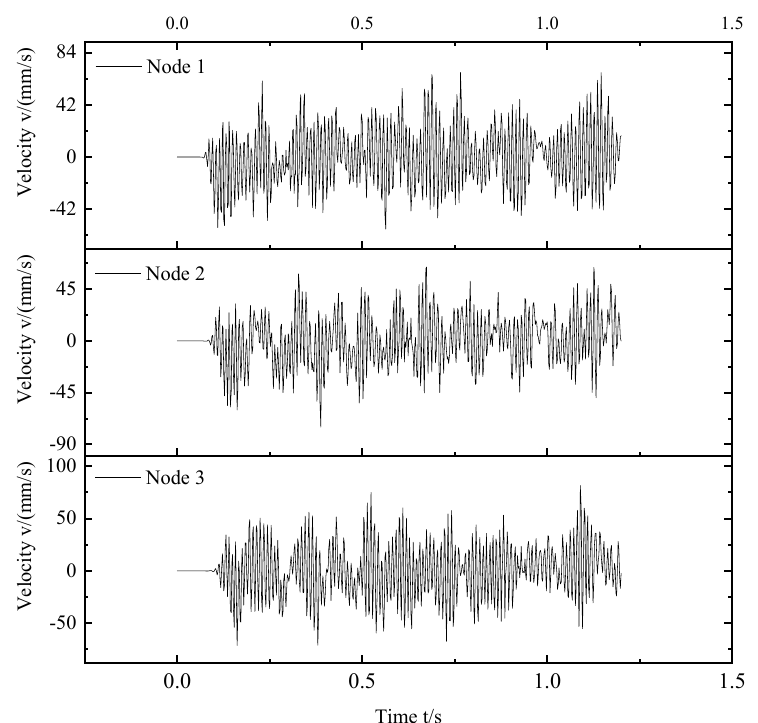
Figure 11. Node velocity time-history curve.